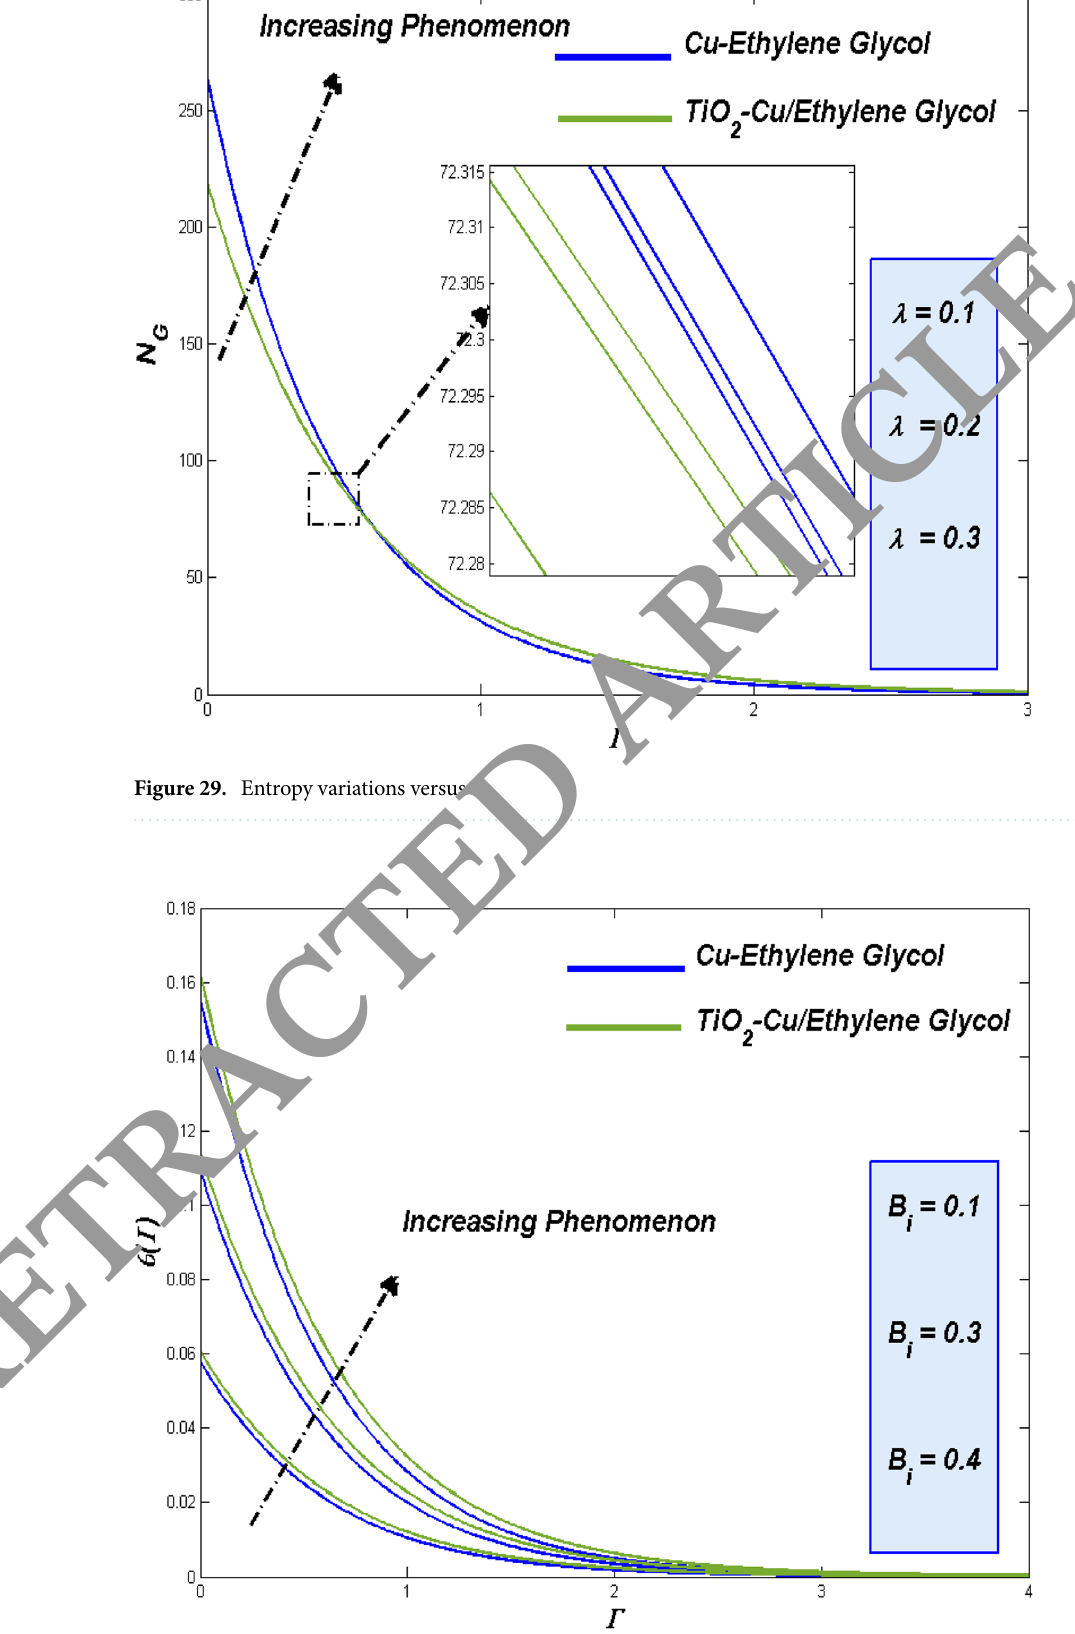
Figure 30. Temperature discrepancy against B i